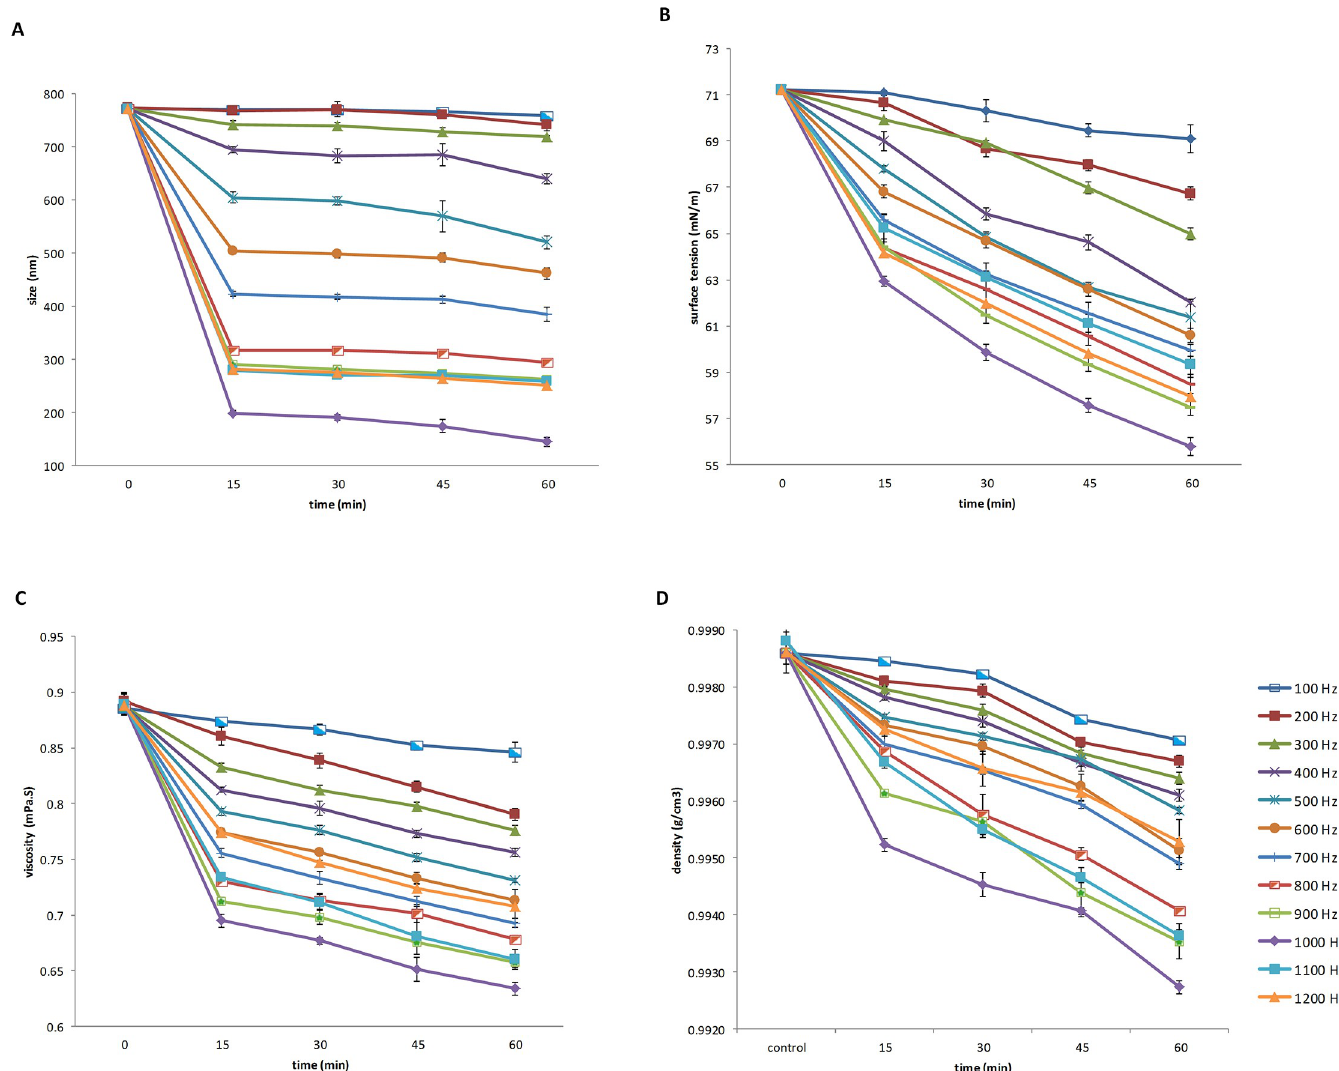
Fig 1. Physicochemical analysis of water. (A) Cluster size analysis. (B) Variation of the dynamic surface tension was measured by Tensiometer. (C) The viscosity of water was determined using a rheometer. (D) The density of water was assessed by a